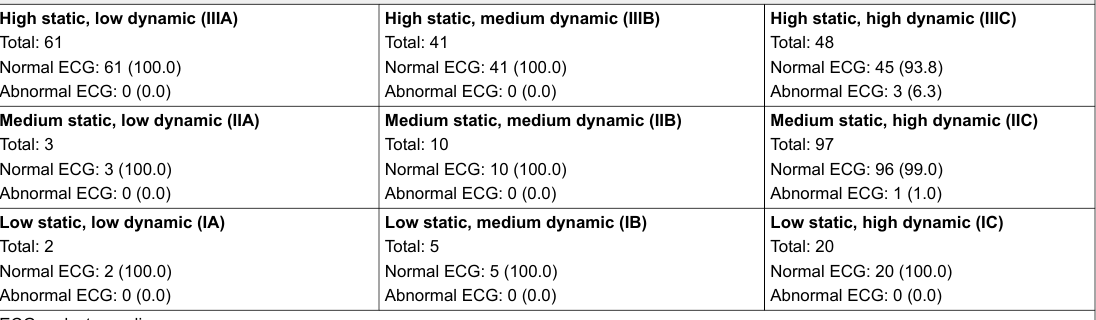
Table 4: Distribution of ECG modifications, as defined in the revised Seattle criteria, according to sports classes by Mitchell [15]. High static, low dynamic (IIIA) Total: 61 Normal ECG: 61 (100.0) Abnormal ECG: 0